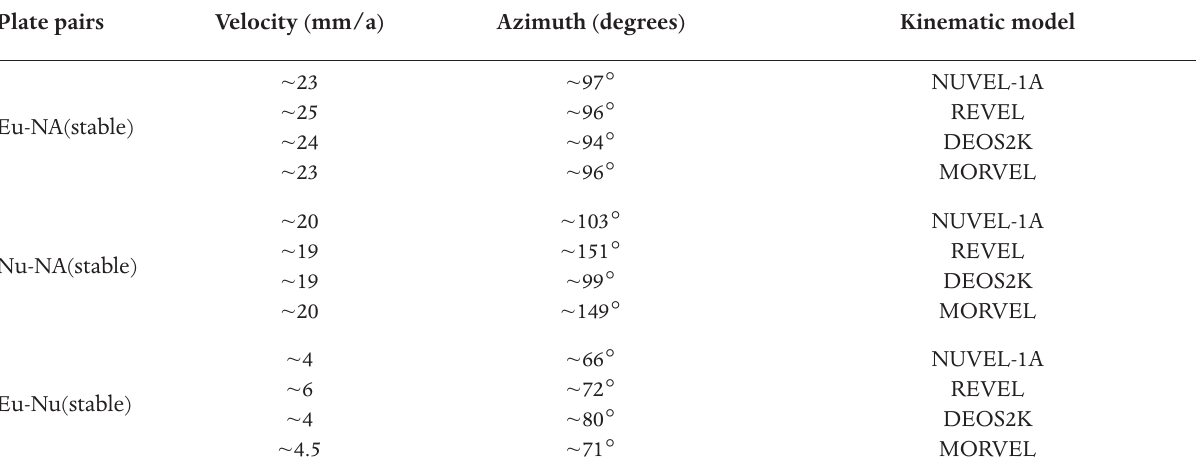
Table 3. Relative velocities and slip directions for Eu, Nu, and NA plates in Azores. Global kinematic models: NUVEL-1A [DeMets et